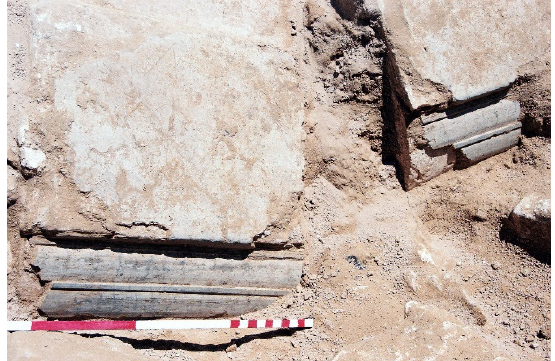
Figure 4. Aedicula from house H10. Remains of flutes of the half column (photo Rafał Czerner).